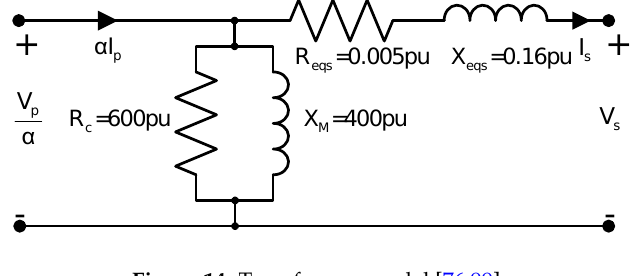
Figure 14. Transformer model [76,99]. Table 6. Multi-Level Modular Converter (MMC) parameters